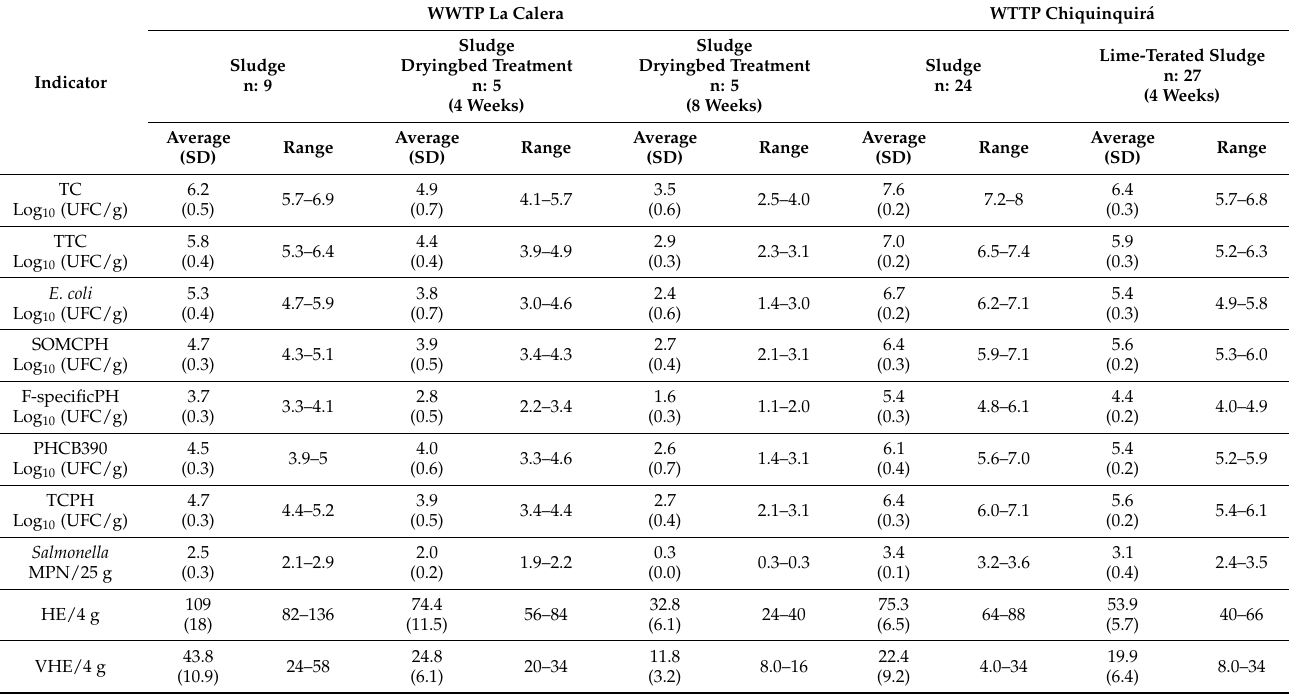
Table A1. Bacterial concentration, viral indicators, Salmonella spp. and helminth eggs in untreated and treated sludge samples collected from La Calera and Chiquinquir á